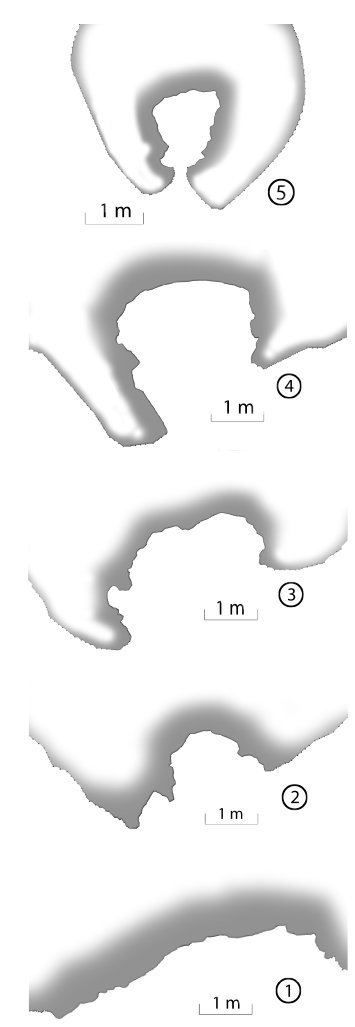
Figure 11. Horizontal sections of the shelter (see the location of the sections in Figure